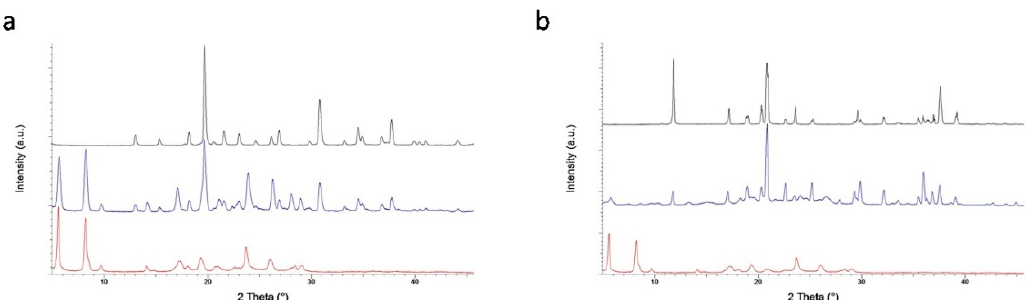
Figure 4. PXRD patterns of: ( a ) CT tetrahydrate (red line), the solid mixture CT_MA (blue line) and MA (black line); ( b ) CT tetrahydrate (red line), the solid mixture CT_TA (blue line) and TA (black line). CT = (+)-Catechin; CT_MA = (+)-catechin_mucic acid adduct; MA = Mucic acid. CT_TA = (+)-catechin_tartaric acid adduct; TA = Tartaric acid.